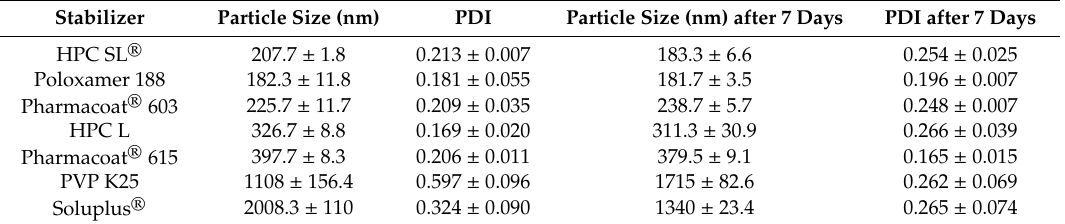
Figure 2. Glimepiride particle size vs. time profiles recorded during wet media milling with different stabilizers. ( a ) HPC-SL, HPC-L, Poloxamer 188, Pharmacoat ® 603 and Pharmacoat ® 615; ( b ) Soluplus ® and PVP K25. Polymers have been grouped according to Z-average diameter scale, for clarity. Table 1. Particle size (z-average) and polydispersity index (PDI) of glimepiride suspension after 60 min of milling and after 7 days storage in a refrigerator (Mean ± SD).